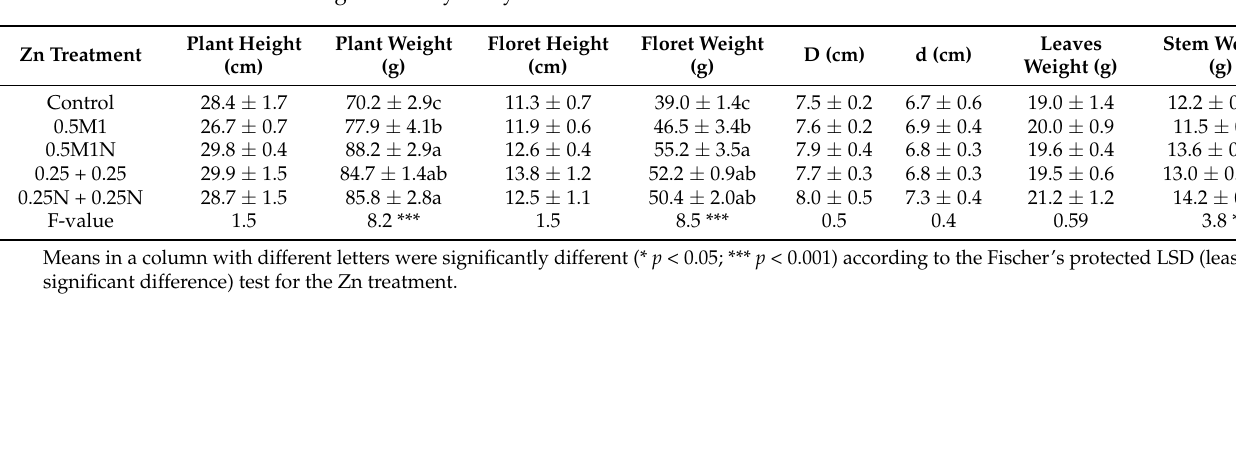
Table 1. Broccoli growth characteristics under different agronomic Zn biofortification treatments (plant and floret heights and weights, maximum (D), and minimum (d) diameters), and leaves and stem weights mean ± standard error of the mean; F-values are derived following a one-way analysis of variance for Zn treatments.